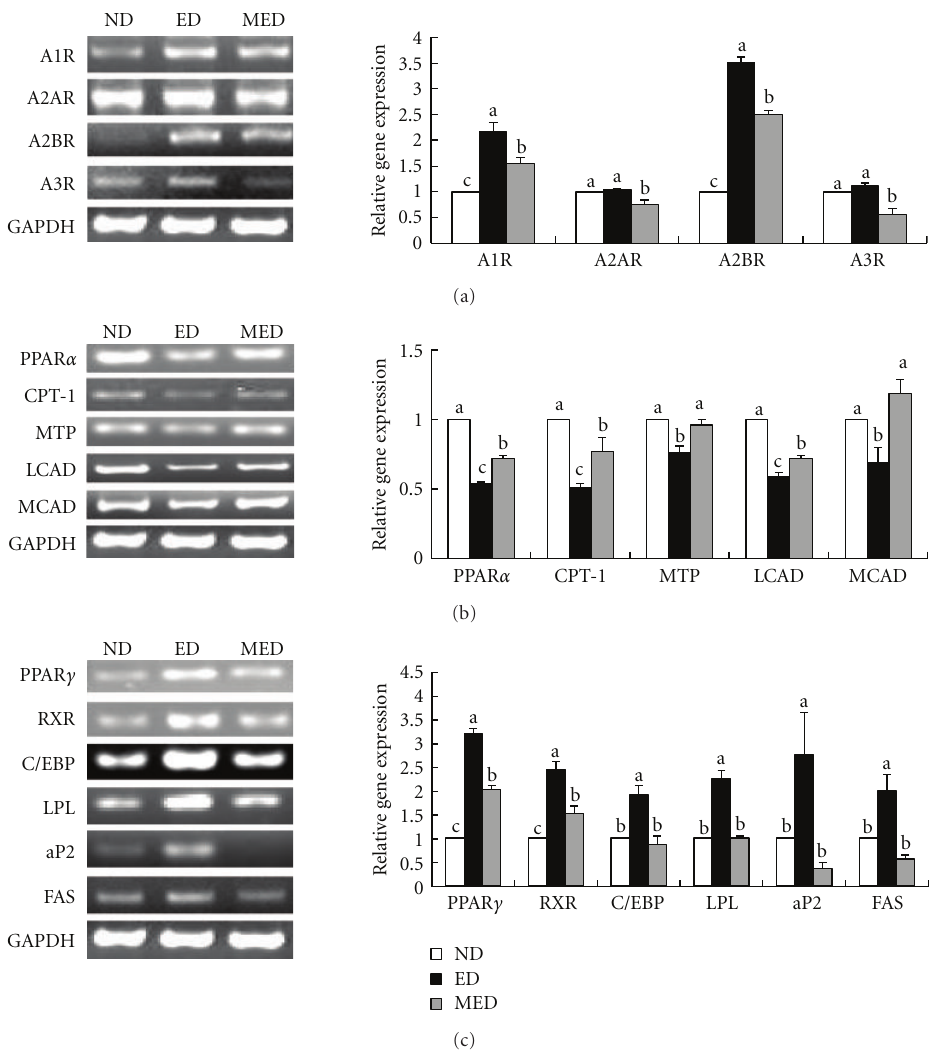
Figure 2: mRNA expression of the hepatic genes that are involved in fatty acid oxidation or adipogenesis. The left panel shows an RT-PCR analysis of (a) A1R, A2AR, A2BR, and A3R (b) PPAR α , CPT-1, MTP, LCAD, and MCAD and (c) PPAR γ , RXR, C/EBP α , LPL, aP2, and FAS expression. The images show the representative agarose gel electrophoresis of the PCR products. The right panel shows the relative expressions of (a) A1R, A2AR, A2BR, and A3R (b) PPAR α , CPT-1, MTP, LCAD, and MCAD and (c) PPAR γ , RXR, C/EBP α , LPL, aP2, and FAS levels. The data were normalized to the GAPDH levels, and all the expression levels that are displayed are relative to the ND. The results that are shown represent the means ± SEM of the three independent experiments in which RNA samples from eight mice were used. a,b,c Means not sharing a common letter are significantly di ff erent ( P < 0 .